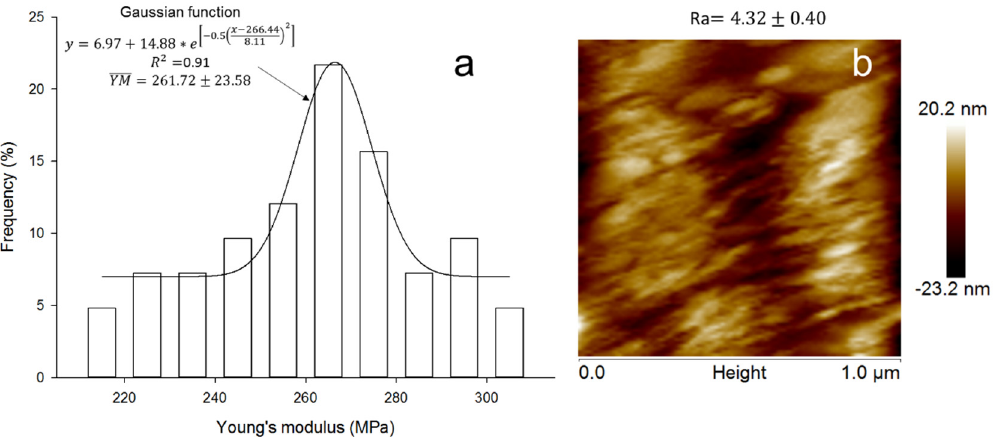
Figure 7. Frequency histogram of YM values, YM: Young’s modulus. The line indicates the fit with a Gaussian function ( a ). AFM height image (1 × 1 µm) of pericarp. Ra: roughness ( b ).